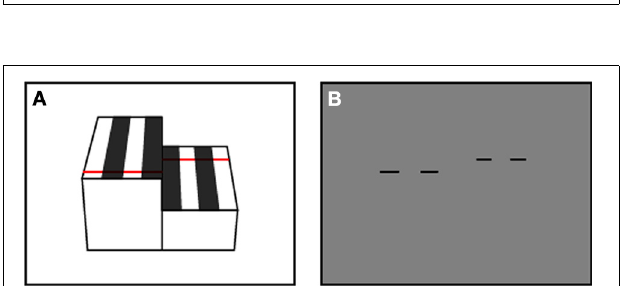
FIGURE 4 | The calibration setup. The pulsed laser shines onto two striped blocks of different height. (A) Schematic view. (B) Schematic of the DVS output: the laser is absorbed by the black stripes and only the white stripes generate